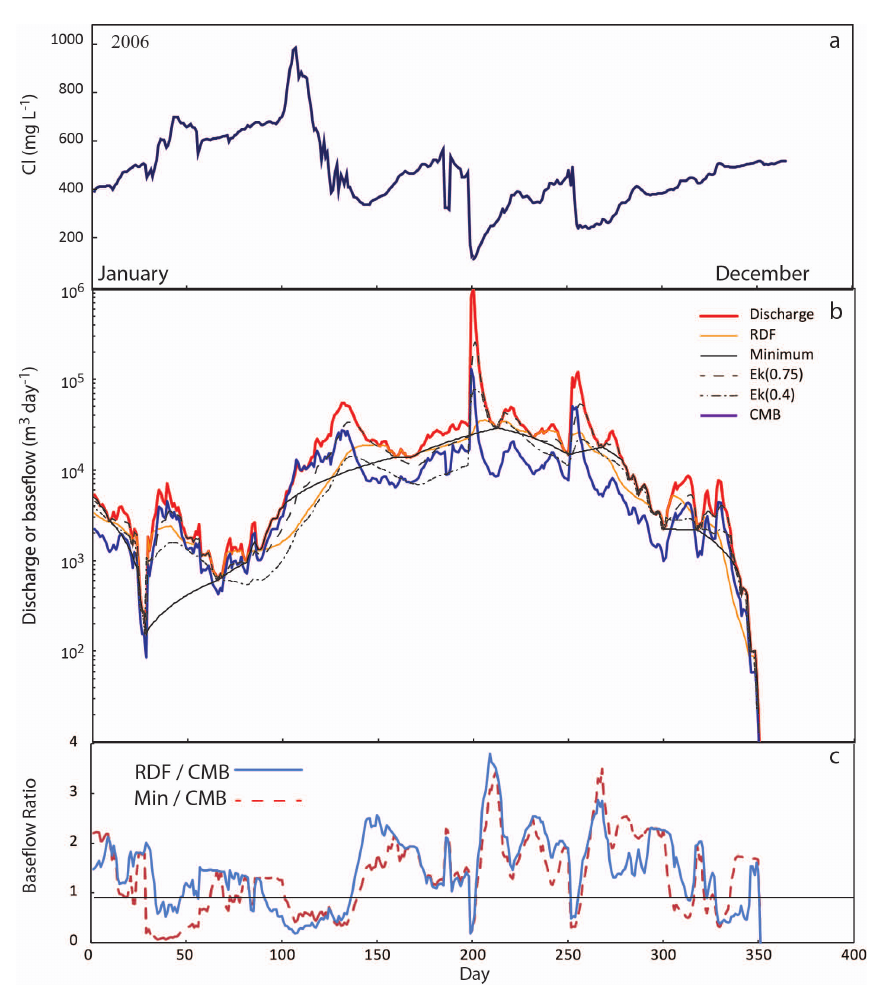
Fig. 5. (a) Variation in Cl concentrations in the upper Barwon River at Winchelsea in 2006. (b) Variation in discharge of the Barwon River at Winchelsea in 2001 and estimated baseflow calculated by the Nathan and McMahon (1990) implementation of the Lyne and Hollick (1979) digital filter (RDF), local minimum (Sloto and Crouse, 1996) (Min), the Ekchardt (2005) digital filter with BFI max =0.75 (Ek(0.75)) and 0.4 (Ek(0.4)), and chemical mass balance (CMB). (c) Ratio of baseflows derived by local minimum and the Lyne and Hollick (1979) digital filter to that estimated by chemical mass balance. Days are from 1 January. Data from Water Resources Data Warehouse